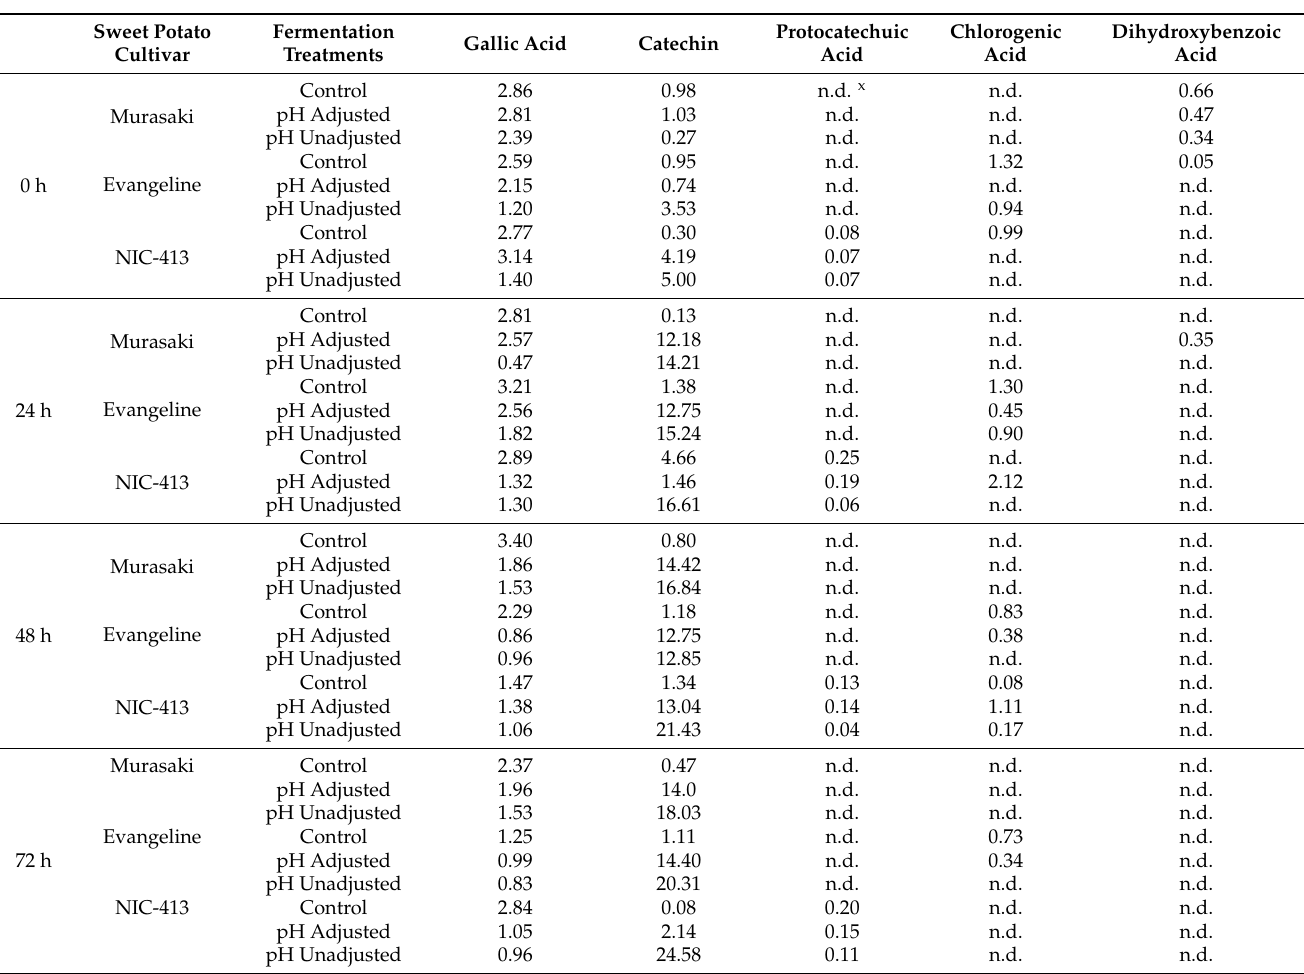
Table 1. Major phenolic compounds ( µ g/g FW) ( n = 6) in LAB fermented and unfermented sweet potatoes at 0, 24, 48, and 72 h fermentation time